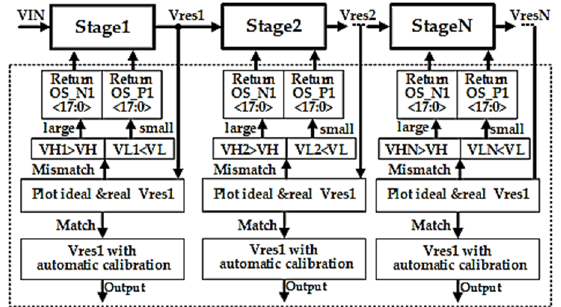
Figure 11. Automatic calibration of residual curves.